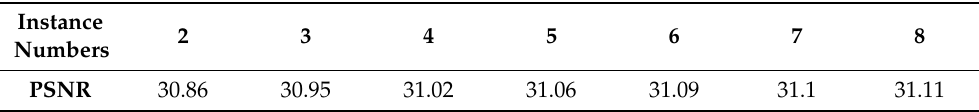
Table 2. Averaged PSNR (dB) of the Set12 dataset while using different numbers of intermediate instances for image